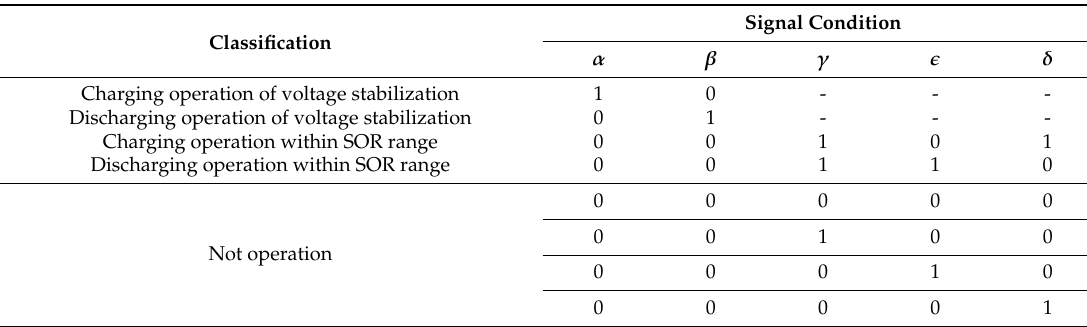
Table 2. Operation signal classification of an energy storage system